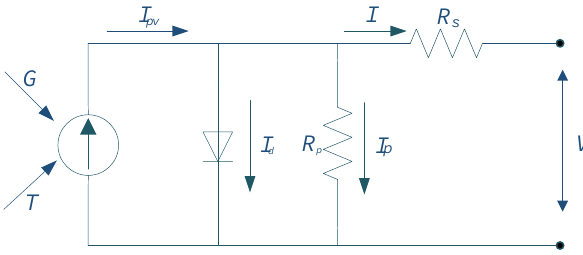
Figure 1. Equivalent electrical circuit of a PV module.